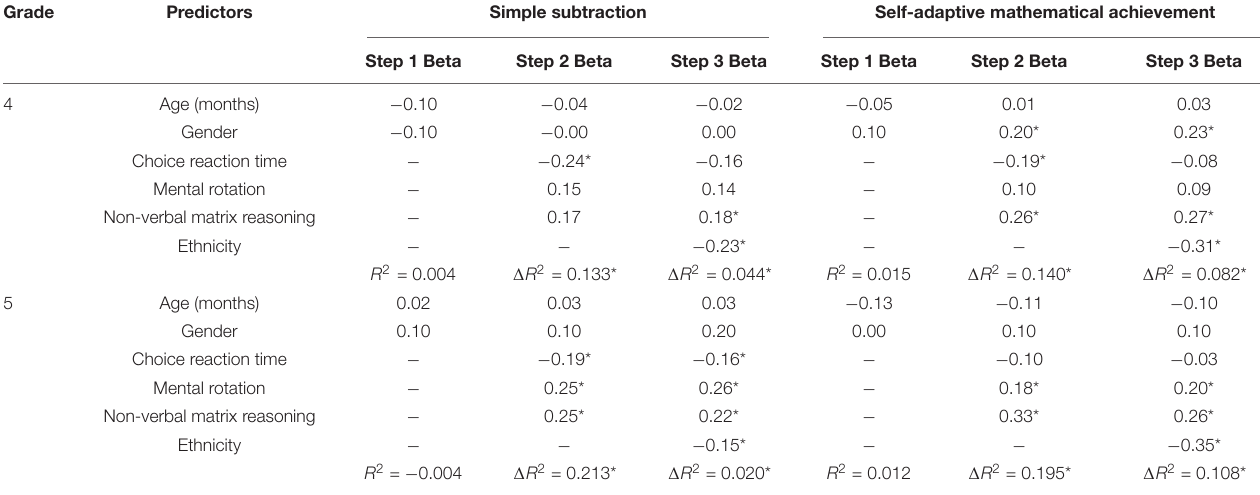
TABLE 4 | Hierarchical regression models predicting simple subtraction and self-adaptive mathematical achievement from age, gender, general cognitive processing, and ethnicity.